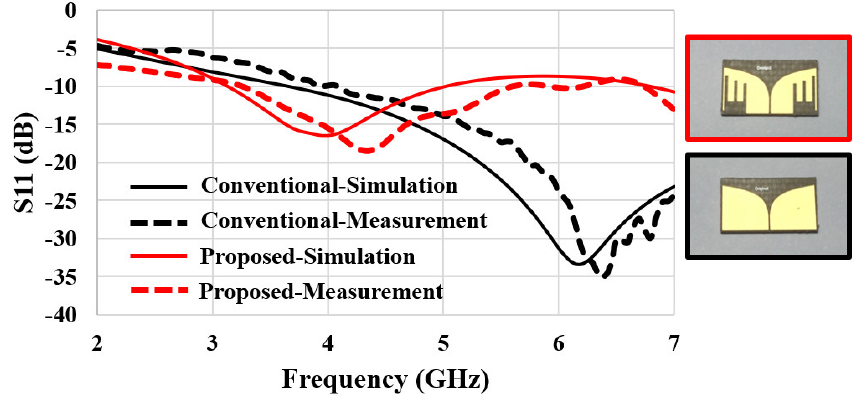
Figure 10. Comparisons of measured and simulated S 11 of conventional and proposed Vivaldi antennas.